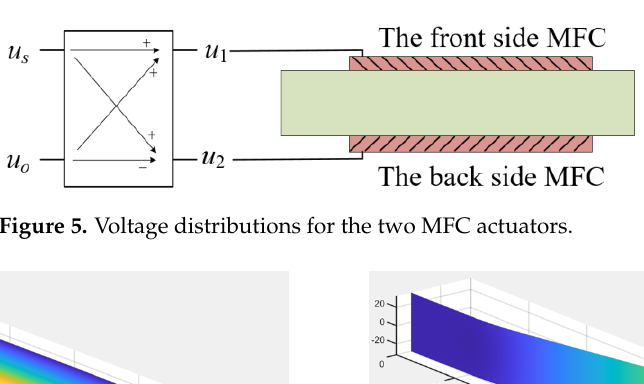
Figure 4. Deformation configuration of the substrate plate actuated by the single MFC. ( a ) Deformation configuration of the substrate plate actuated by the MFC1; ( b ) deformation configuration of the substrate plate actuated by the MFC2.